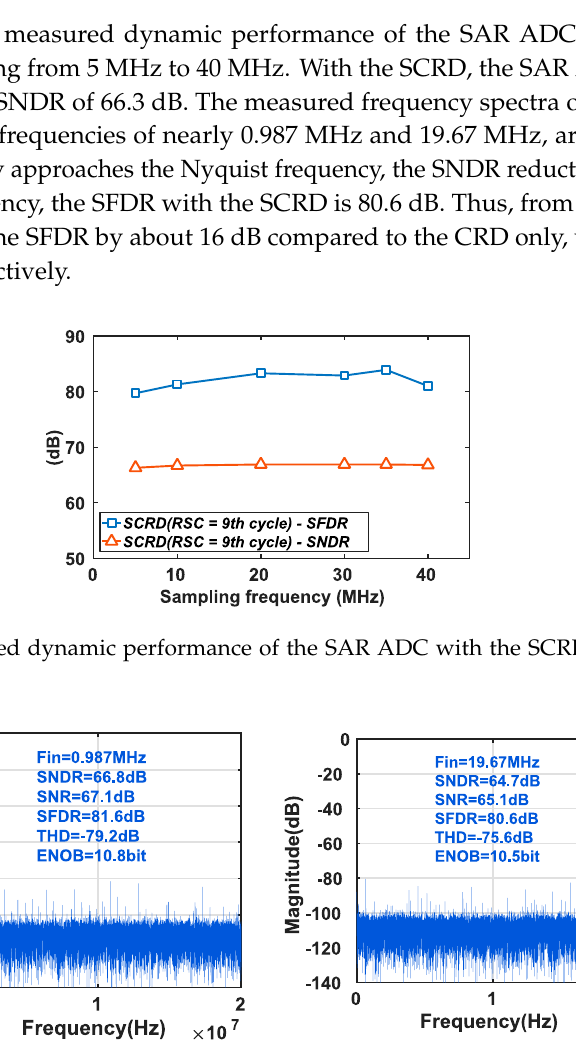
Figure 16. Die photograph.